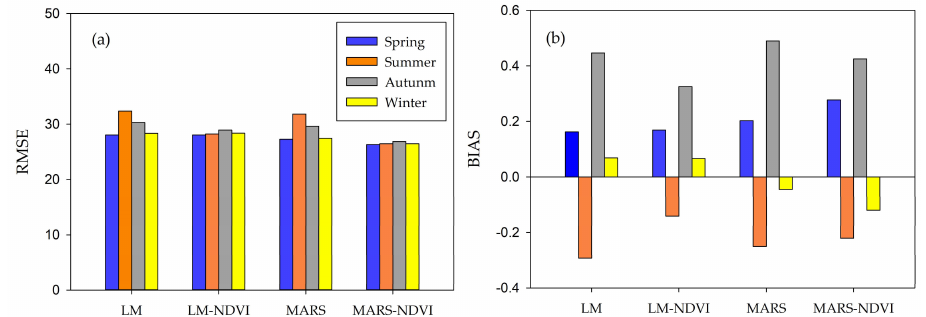
Figure 7. Validation results of the four developed models for spring, summer, autumn, and winter: ( a ) RMSE and ( b )